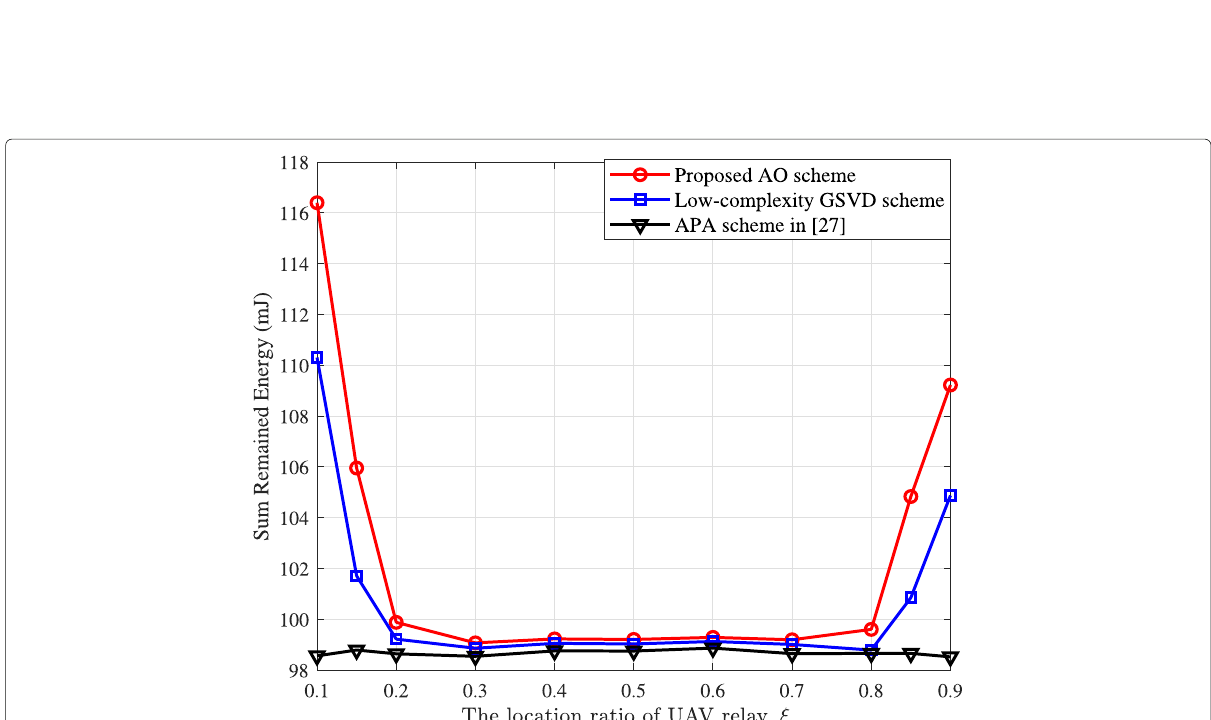
Fig. 5 Sum remained energy versus the location ratio of UAV relay ξ , P R , Max = 25